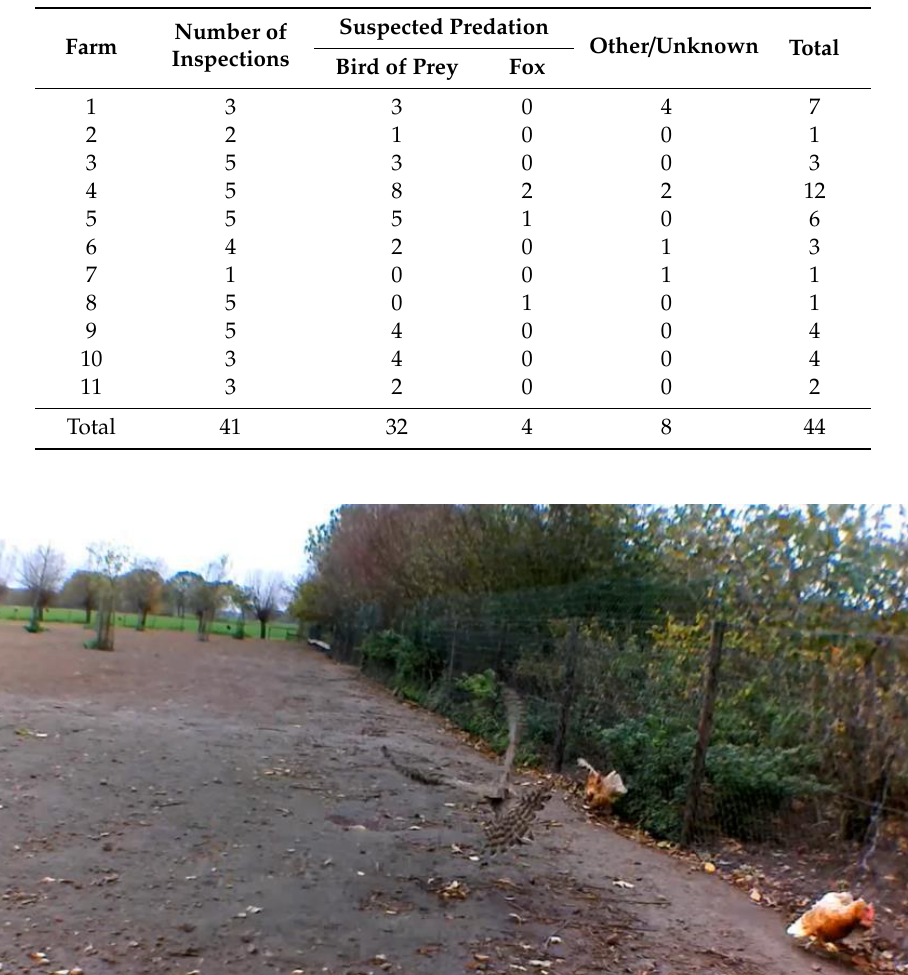
Table 4. Numbers of hens found dead during inspections carried out on foot and their assumed cause of death.